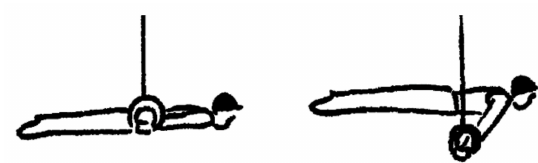
Figure 1. Swallow and support scale. Perfect execution of the swallow ( left ) and support scale ( right ) strength hold elements on rings, which must be maintained for 2 s according to the code of points